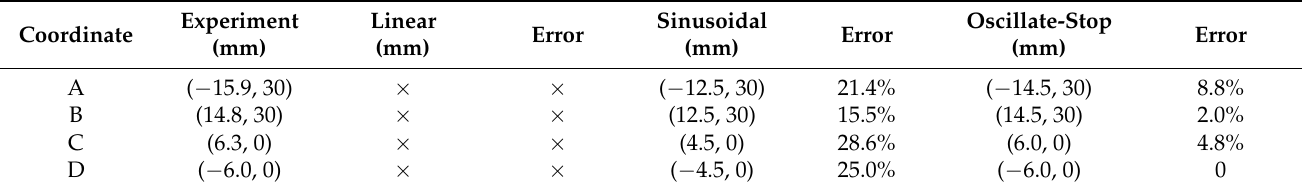
The “×” sign refers to the lack of fusion at the given location, i.e., no fusion line in the area.